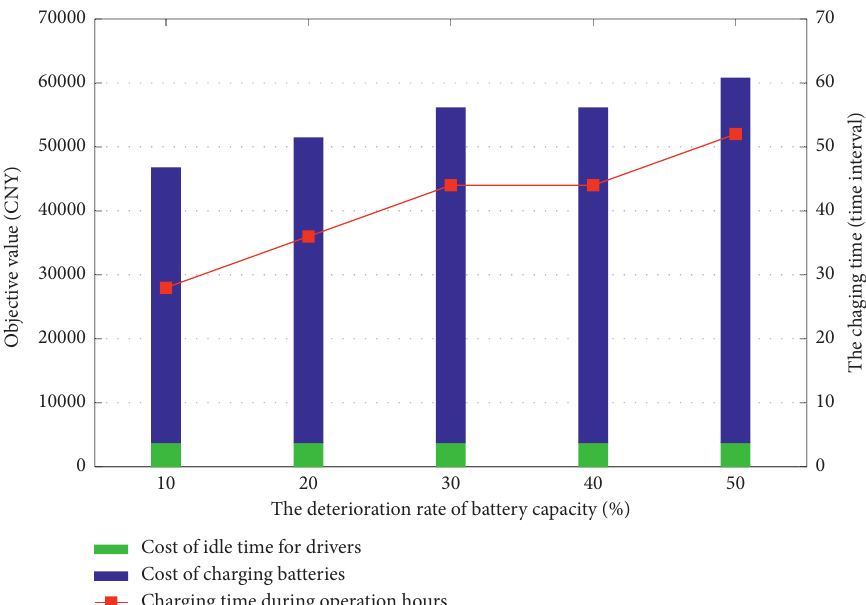
Figure 11: Effect of the initial driving range on the objective value and charging time during operation hours.